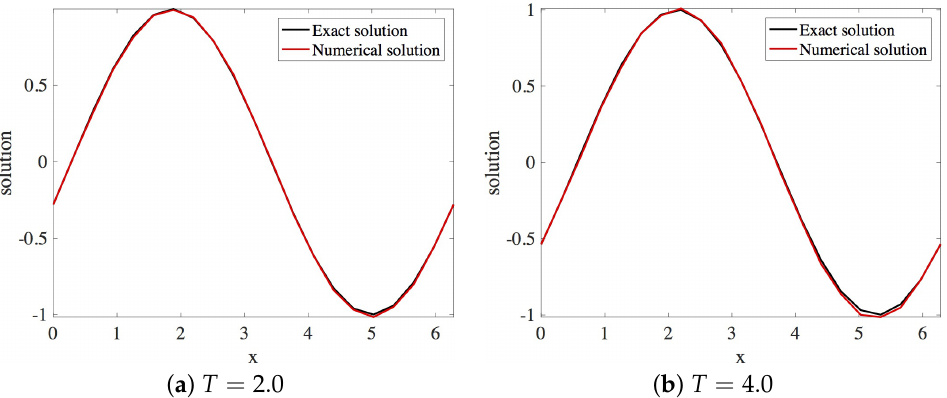
( a ) T = 2.0 Figure 18. Plot of exact and numerical profiles (using Scheme 1) vs. x at times 2.0 and 4.0 using h = π /10 and k = 0.001 (Numerical Experiment